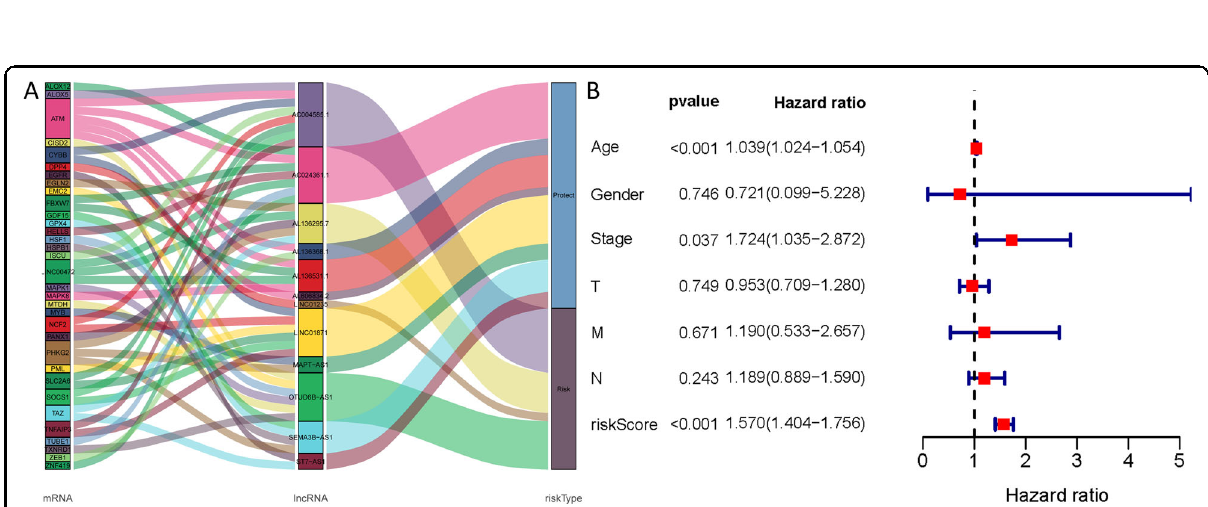
Fig. 6 The correlation between immune cell subpopulations and related functions based on ssGSEA in high (red) and low (blue) risk groups, and the differences in the expression levels of immune checkpoints between the high (red) and low (blue) risk groups. A Immune function; B Immune checkpoints.